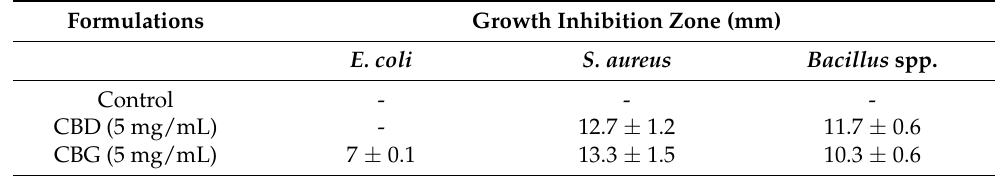
Table 4. Growth Inhibition zones of CBG and CBD formulations on E. coli , S. aureus and Bacillus spp. strains.